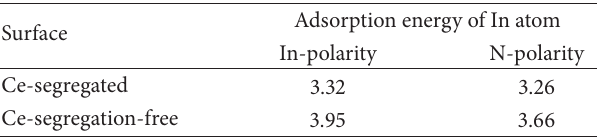
Table 4: Adsorption energies (in eV) of an In atom on the nitrogen layer covering CeSZ (111)